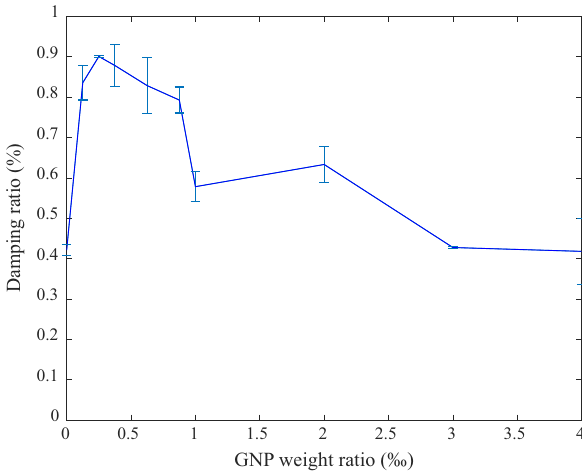
Figure 12: First - order damping ratios of the composite beams rein - forced by GNP through vibration